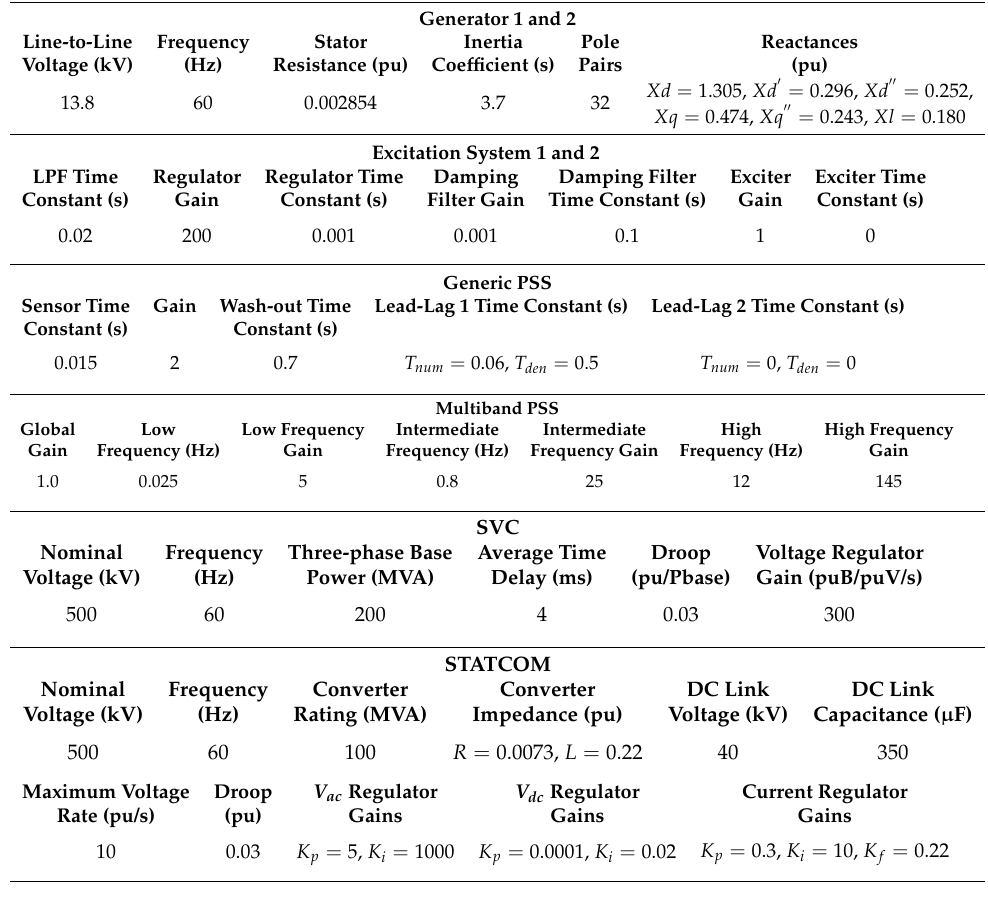
Table A2. Parameter values of the components of the